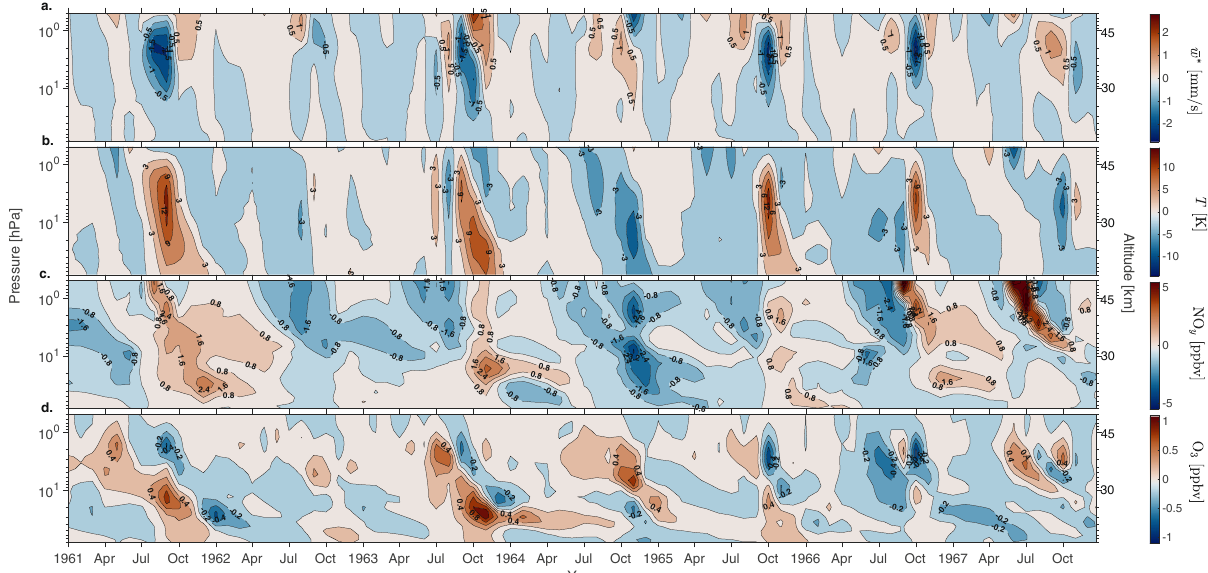
Fig.1|Representativeannualstratosphericvariability. Monthlymeananomalies in( a .)residualverticalwind, w * (0.5mms − 1 contourinterval),( b .)temperature, T (3 K contour interval), ( c .) nitrogen family, NO y (NO x , HNO 3 , N 2 O 5 , ClONO 2 , HNO 4 ) (0.8 ppbv contour interval), and ( d .) ozone, O 3 (0.2 ppmv contour interval),